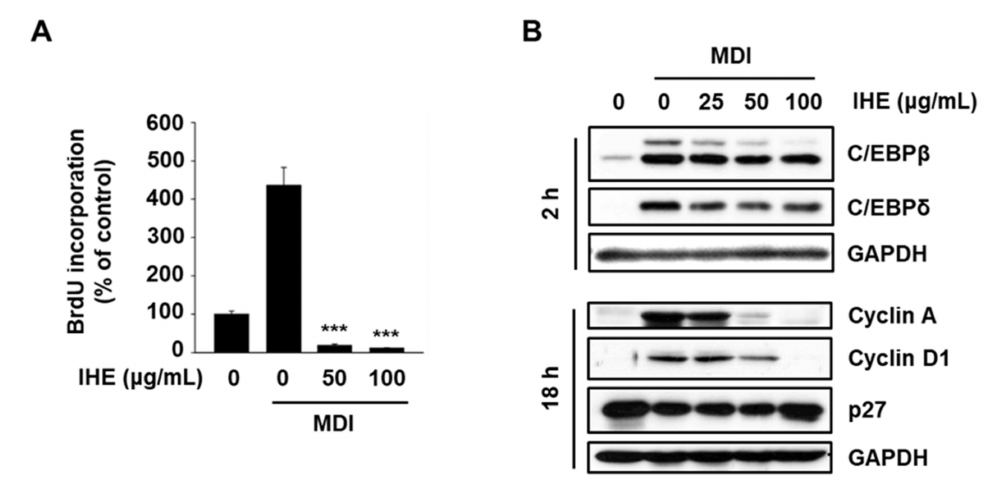
Figure 6. IHE inhibits MDI-induced MCE in growth-arrested 3T3-L1 cells. ( A ) Growth-arrested